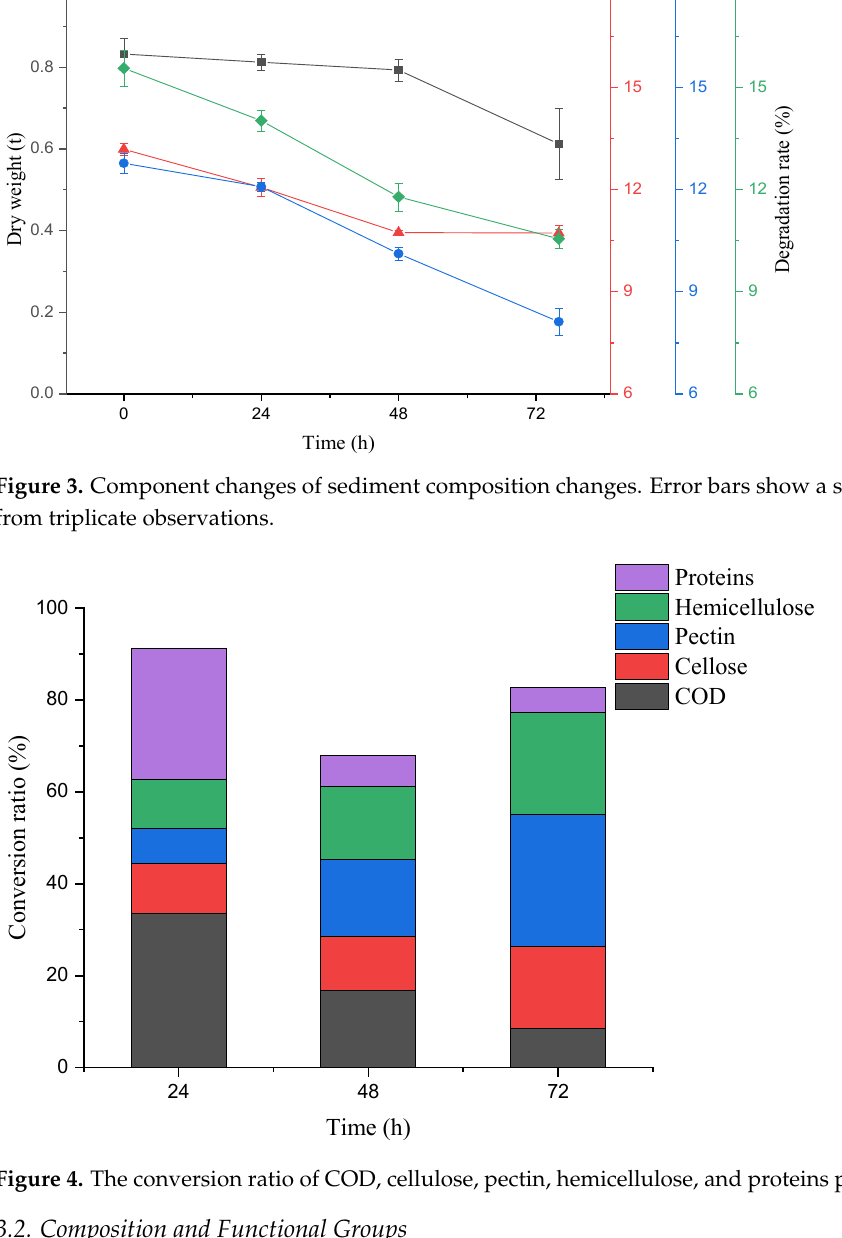
Figure 4. The conversion ratio of COD, cellulose, pectin, hemicellulose, and proteins per 24 h.